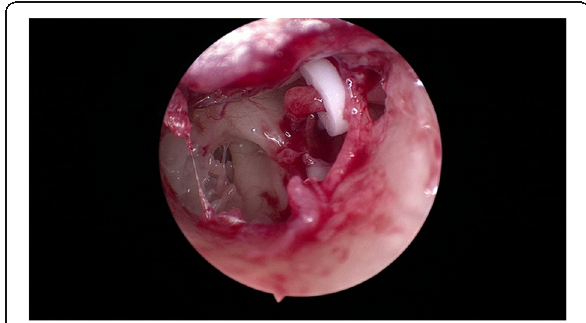
Fig. 4 Teflon prosthesis is inserted, loop around the long process of incus, and base of the shaft at stapedotomy